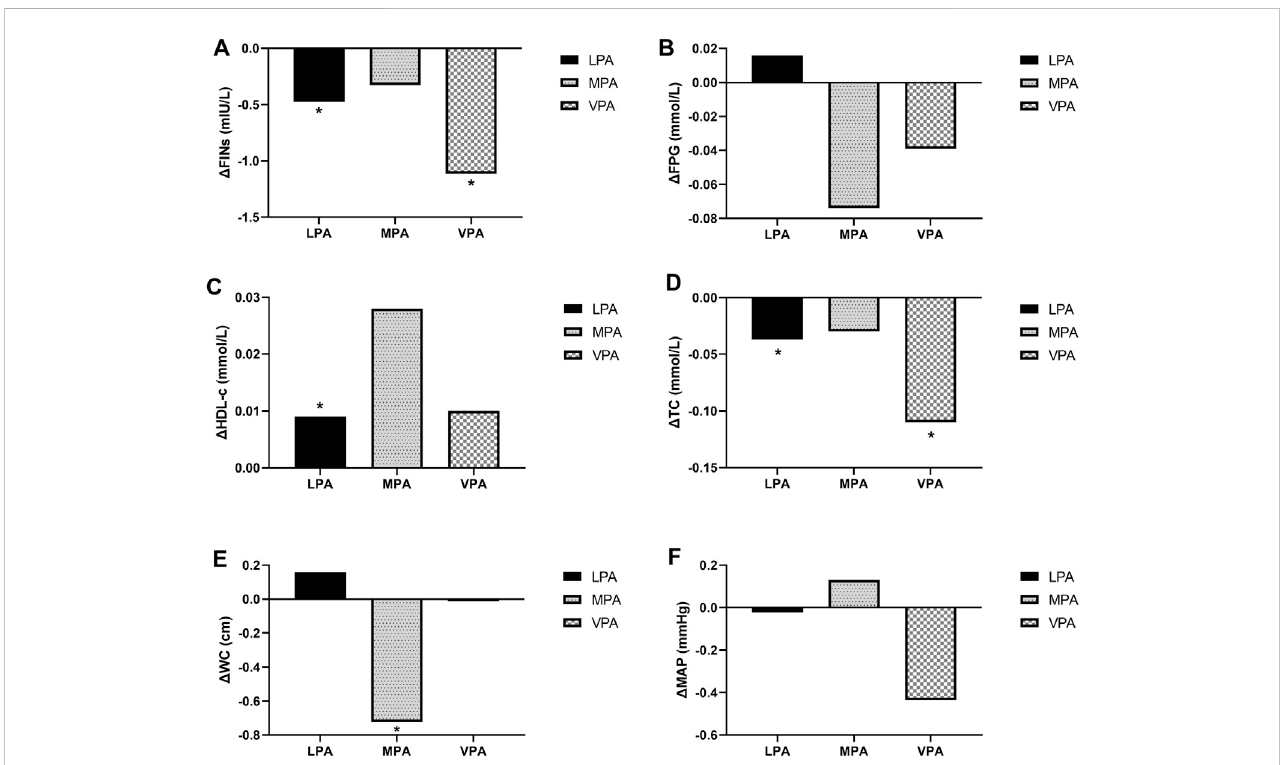
FIGURE 2 Effect of 10 min of different intensity physical activity substitution for SB on CMR factors: The difference of FINs (A) , FPG (B) , HDL-c (C) , TC (D) , WC (E) , MAP (F) . *, P < 0.05. Corrections for gender, age, and REE when building the ISM. FINs, Fasting Insulin; FPG, Fasting Plsma Glucose; HDL-c, High-density Lipoprotein Cholesterol; LPA, Light Physical Activity; MAP, Mean Artery Pressure; MPA, Moderate Physical Activity; TC, Total Cholestero; VPA, Vigorous Physical Activity; WC, Waist Circumferencel.